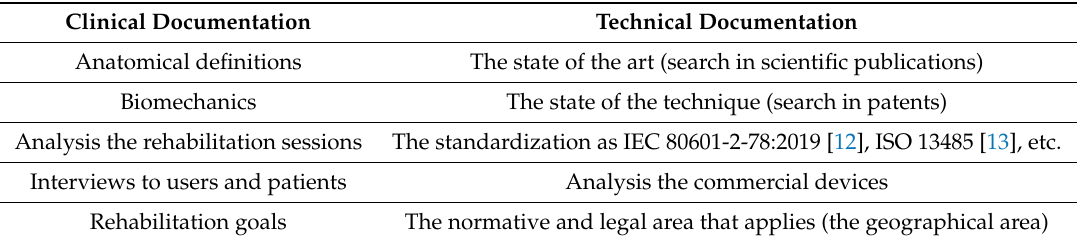
Table 1. Documentation clinical and